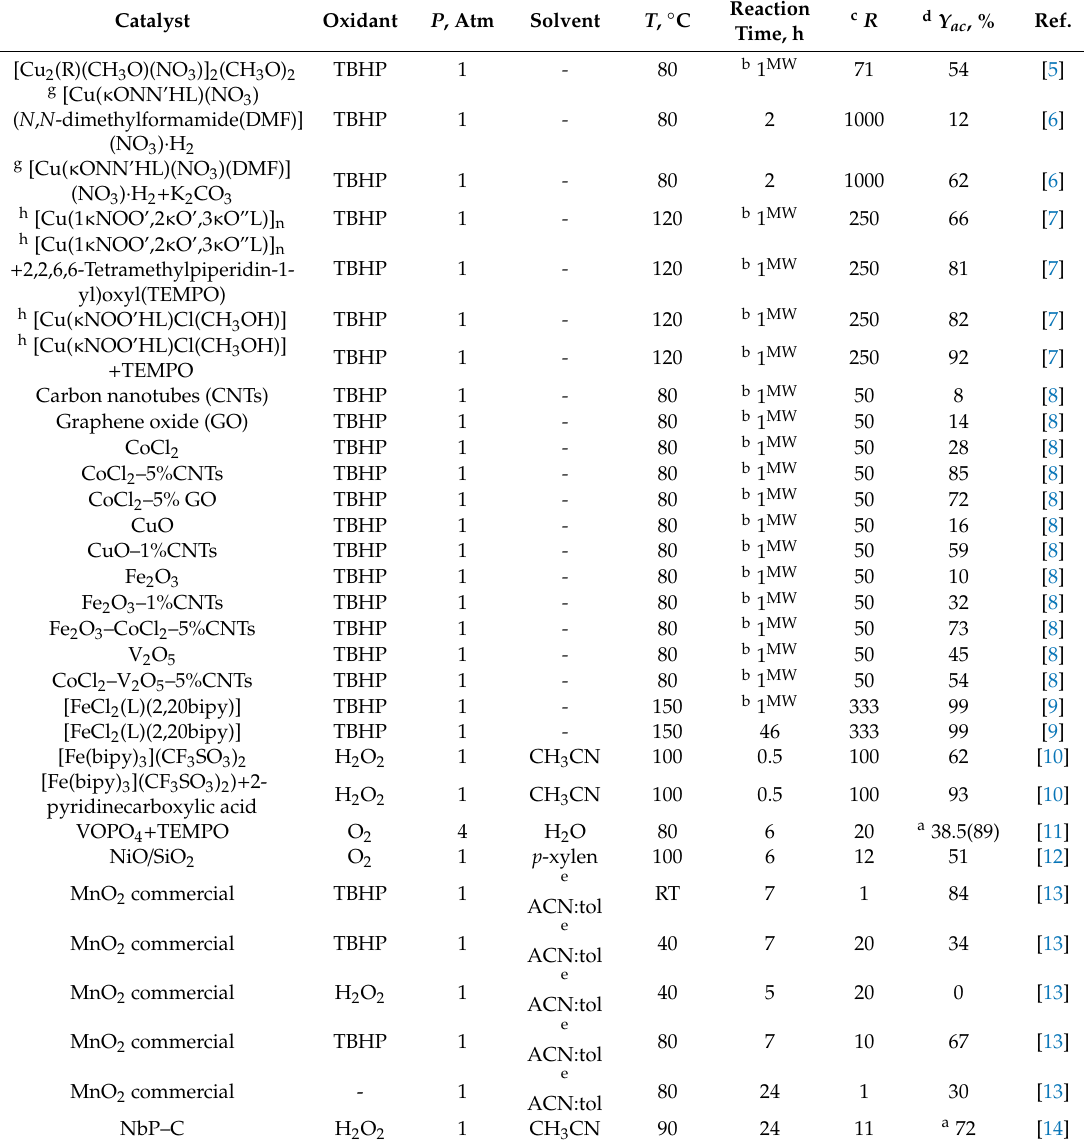
Table 1. Catalytic oxidation of 1-phenylethanol using homogeneous and heterogeneous catalysts. Catalyst Oxidant P , Atm Solvent T , ◦ C